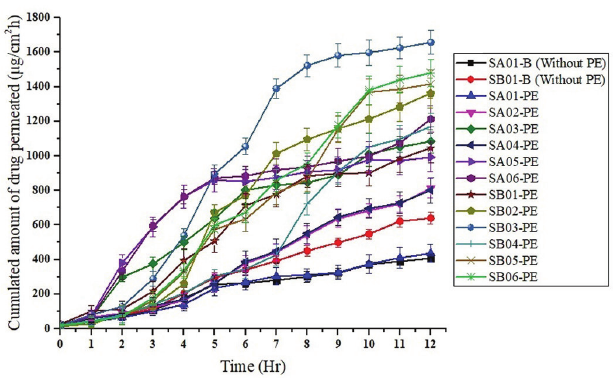
FIGURE 3 - Ex vivo cumulative drug permeated (µg/cm 2 h) from TZD HCl patches containing permeation enhancers. SA01-B and SB01-B represents the control patches (without permeation enhancers). The results are expressed as mean ± SD, n=3.